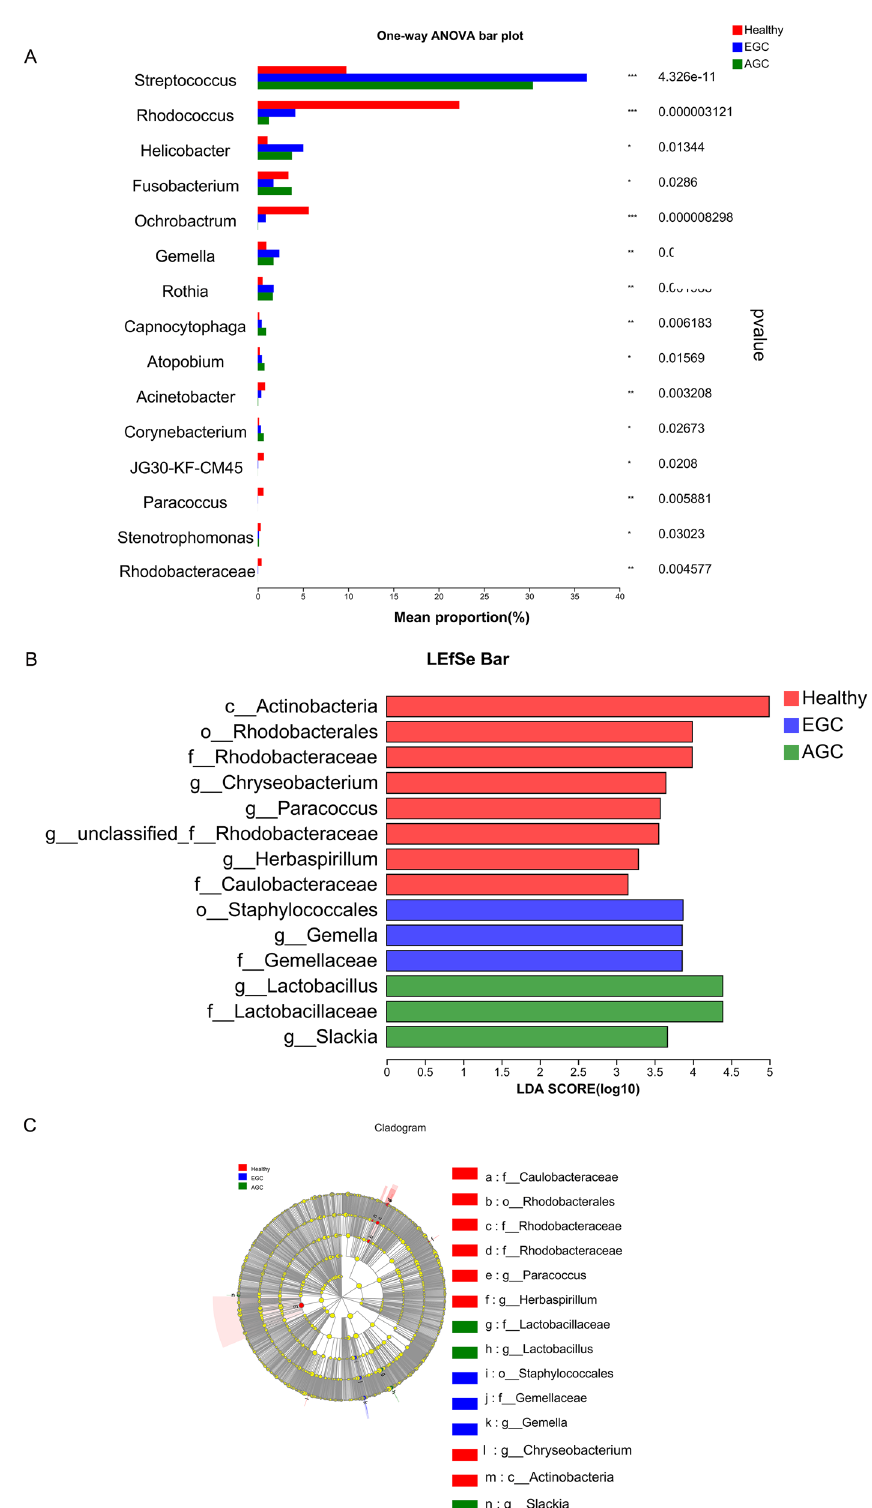
Fig. 6 Multispecies difference test bar chart and diagram of different microflora in the three groups. A The statistical method of Student’s t test was used to test the hypothesis of the species between the microbial communities of the three groups of samples and evaluate the significance level of the difference in species abundance. P < 0.05 indicates a significant difference. The closer the line is to the mid- dle, the smaller the standard deviation and the better the central tendency. B The LDA score was obtained by linear regression analysis, and the greater the LDA score was, the greater the impact of bacterial abundance on the difference effect. An LDA score of more than 2 indicates a statisti- cally significant difference (P < 0.05). C The graph shows LEfSe multistage species from the inner to the outer circle and represents the phylum, class, order, family, genus, and species of different unit levels. Different color nodes indicate the microbial groups that were significantly enriched in the corresponding groups and had a significant influence on the differences. The pale- yellow nodes indicate the microbial groups that had no significant difference among different